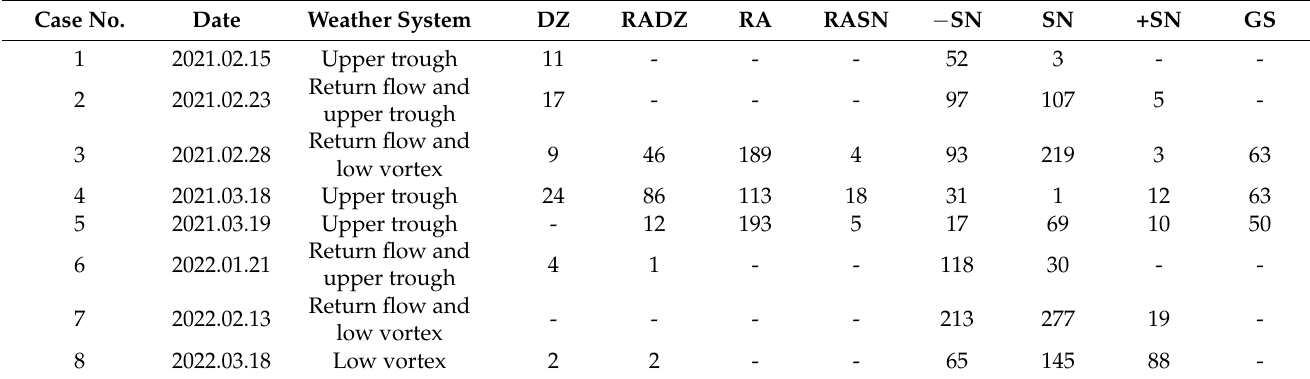
Table 1. The number of samples data for different types of